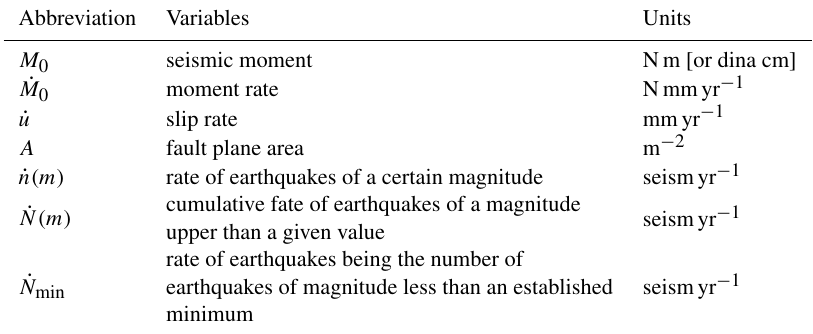
Table A1. Variables and